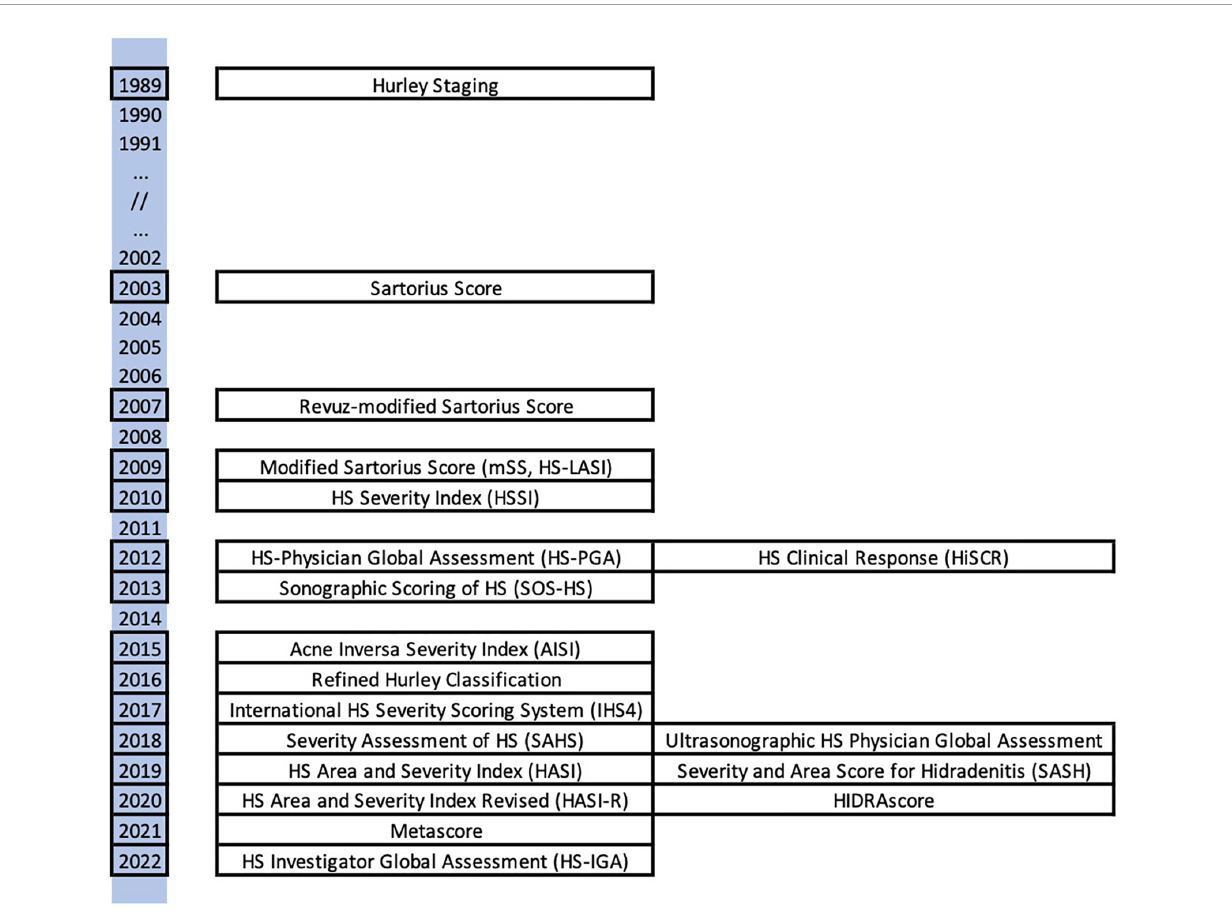
FIGURE1 Illustration of the scores detailed inthis article, spread over a timeline.